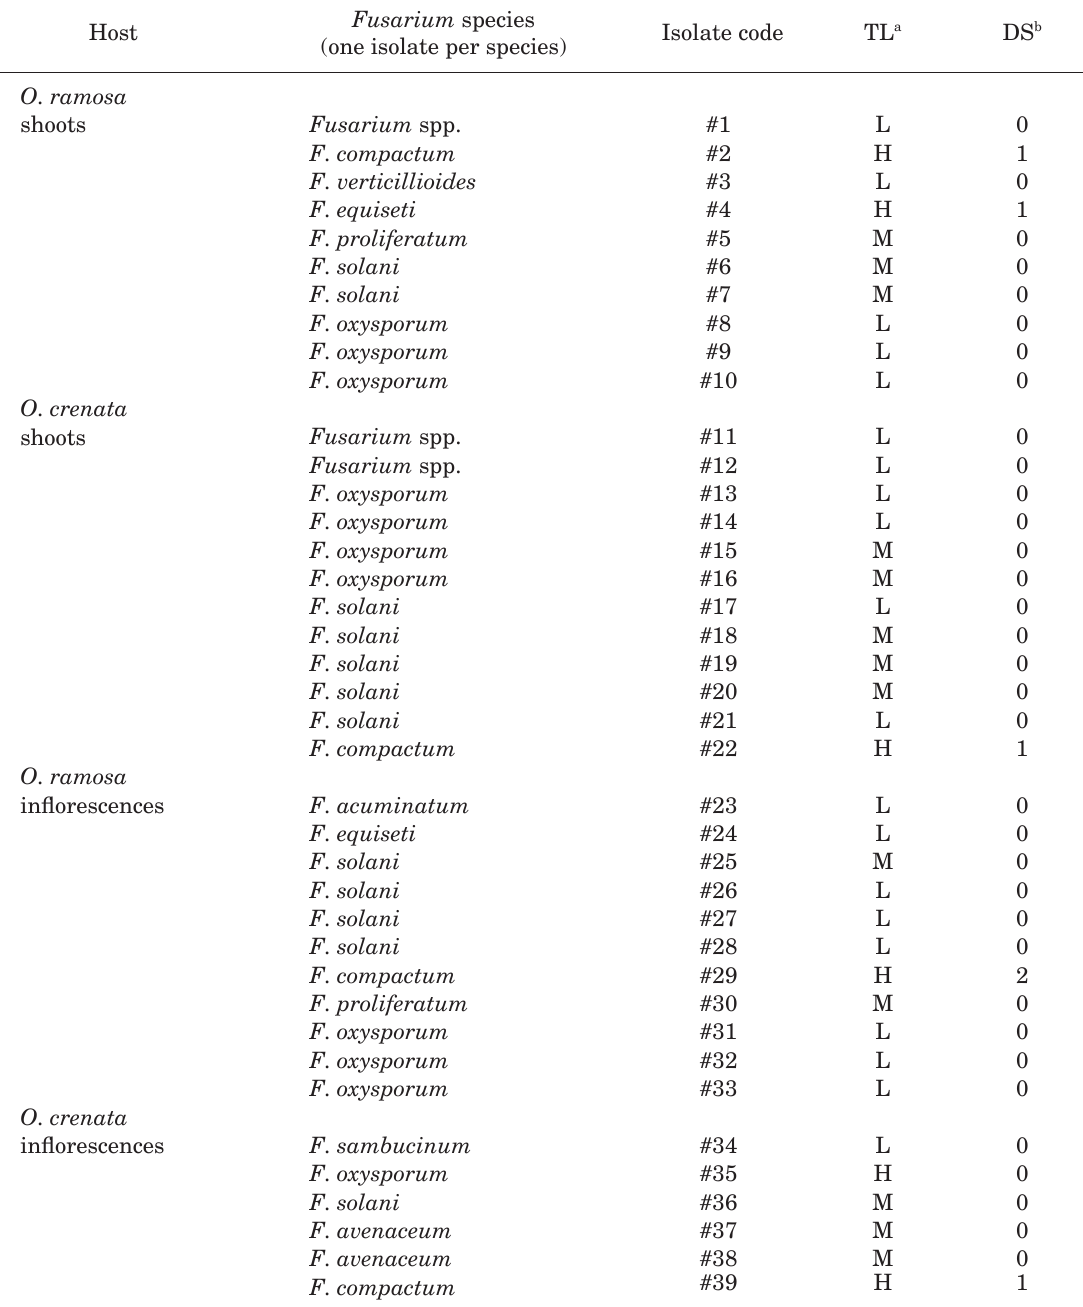
Table 2. Toxicity levels (TL) of Fusarium culture filtrates on the seed germination of hemp broomrape ( Orobanche ramosa ) and disease severity (DS) of Fusarium isolates on O. ramosa in an experiment conducted in plastic bags. One-way ANOVA showed a highly significant differences between the 39 isolates (F=97.6, P